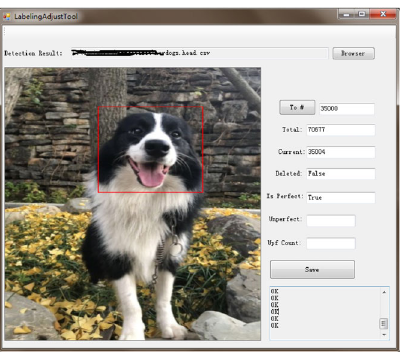
Fig. 4 Snapshots of Tsinghua Dogs Dataset.